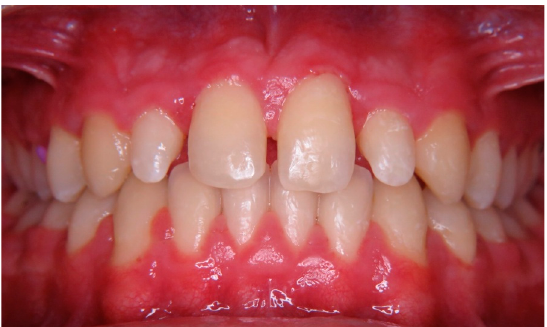
Figure 8. Case 3 preoperative photograph.